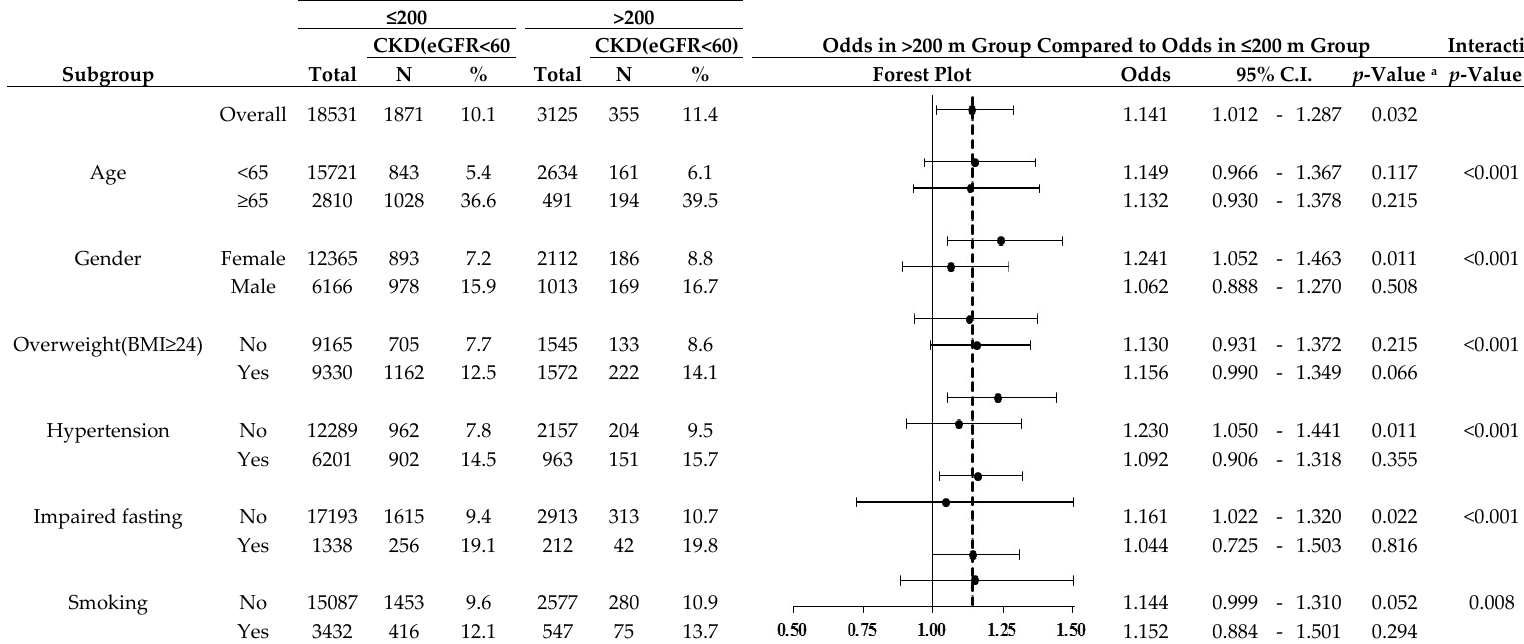
The dashed vertical line indicates the overall odds ratio (1.141), and the solid vertical line indicates no risk (odds ratio = 1.00). p -value a is from test statistics for odds of CKD between distance to open space ≤ 200 m group and > 200 m group; p value b is from test statistics for interaction between distance to open space and subgroup variable.